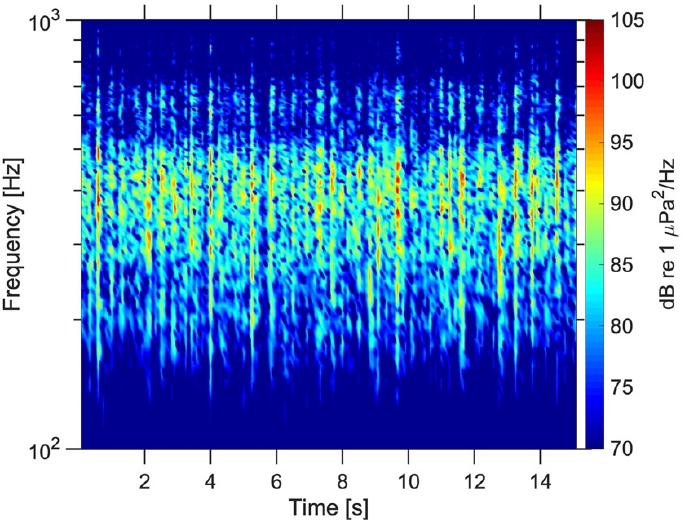
Figure 3. Chorus of pulsed signals likely produced by squid. Frequency-modulated tones (whistles, 6–24 kHz) and pulsed sounds (clicks and burst pulses, 7–24 kHz) produced by dolphins were detected year-round at all sites, but in <10% of inspected samples. Humpback whales ( Megaptera novaeangliae ) were recorded from mid- June until mid-December, with more extensive vocalisations in Algoa Bay than in St. Francis Bay. Energy from calls and songs was most intense between 100 Hz and 1 kHz.